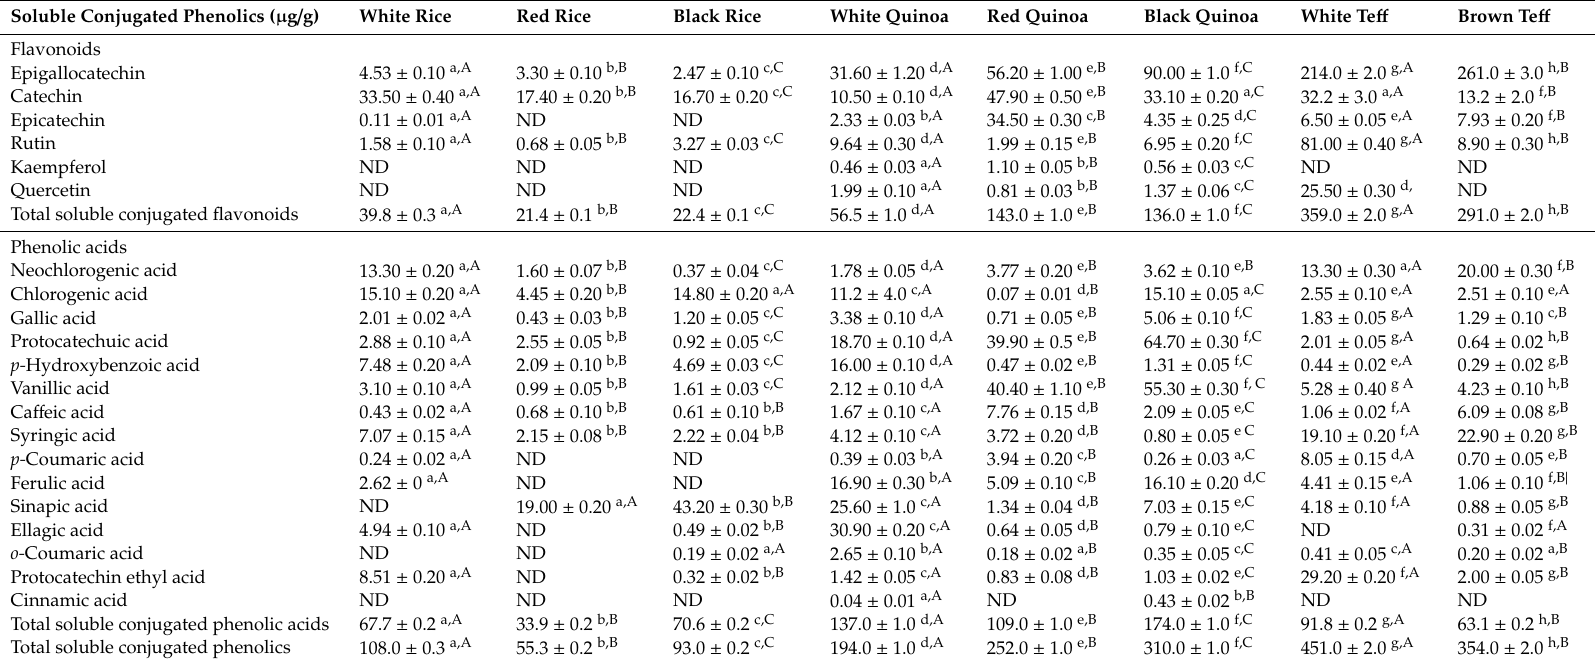
Table 5. Results of individual phenolic concentrations in soluble conjugated phenolic fractions of non-traditional flakes. Soluble Conjugated Phenolics ( µ g /